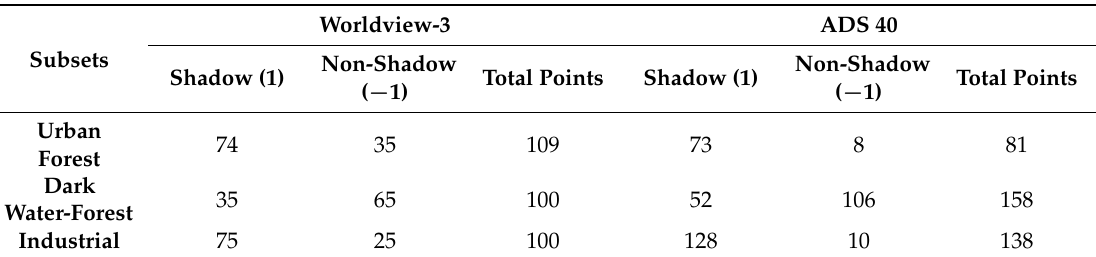
Table 5. Counts of shadow/non-shadow reference points used in image subsets for Worldview-3 and